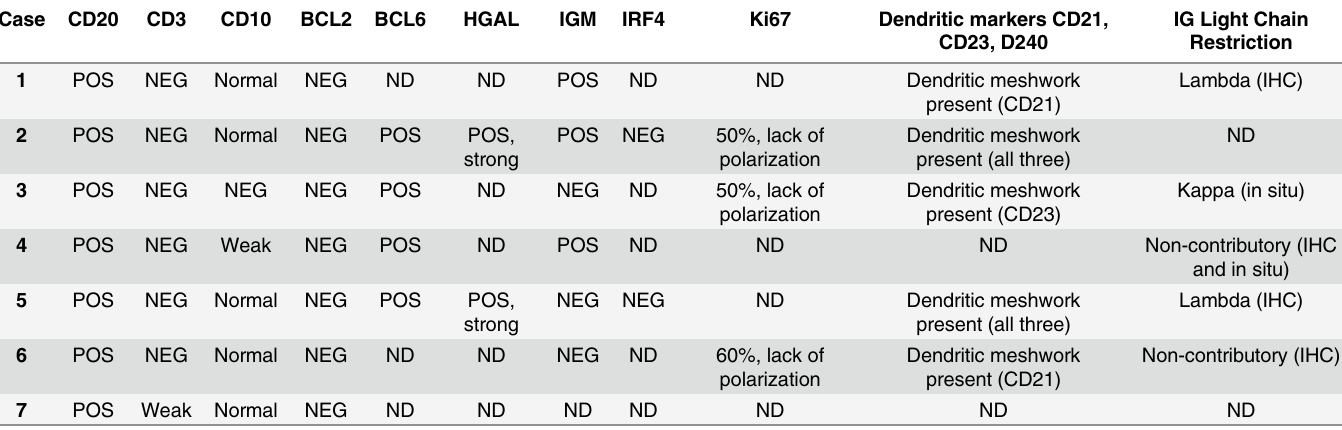
Table 3. Summary of Immunohistologic Findings.